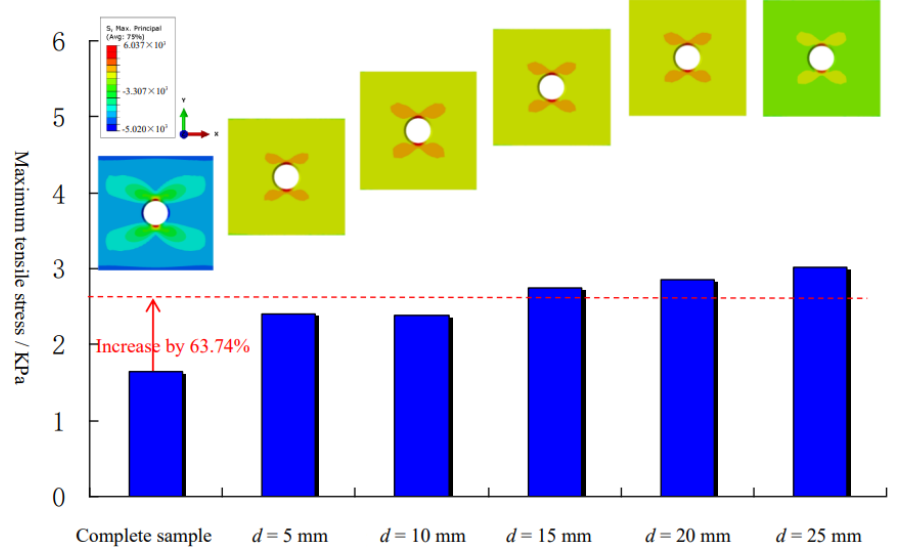
Figure 16. Distribution of maximum tensile stress.